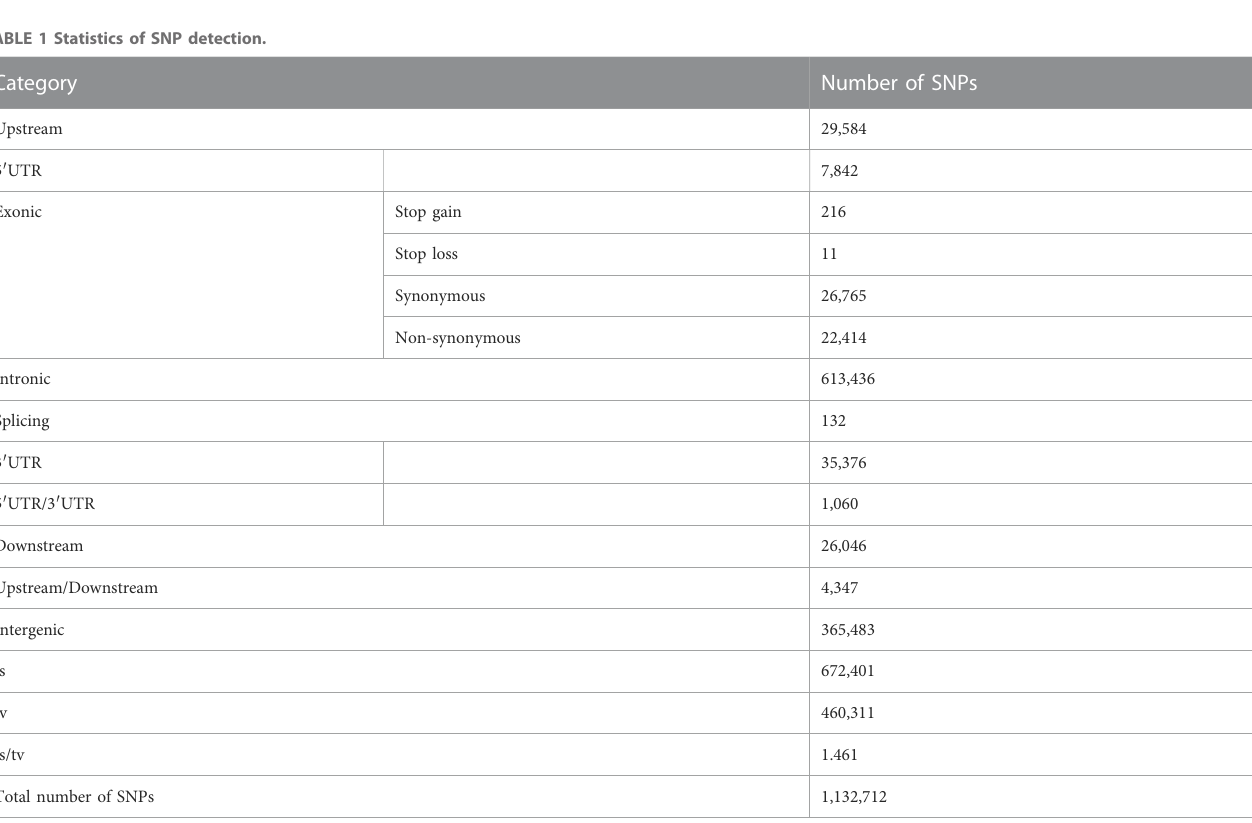
TABLE 1 Statistics of SNP